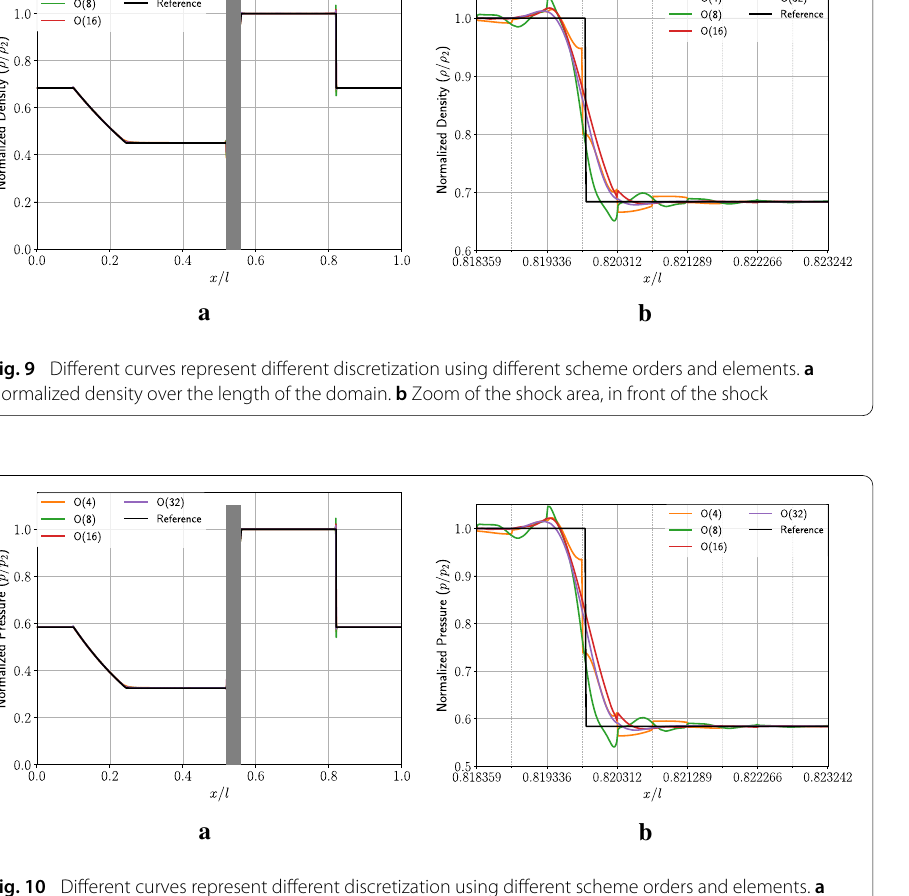
Fig. 10 Different curves represent different discretization using different scheme orders and elements. a Normalized pressure over the length of the domain. b Zoom of the shock area, in front of the